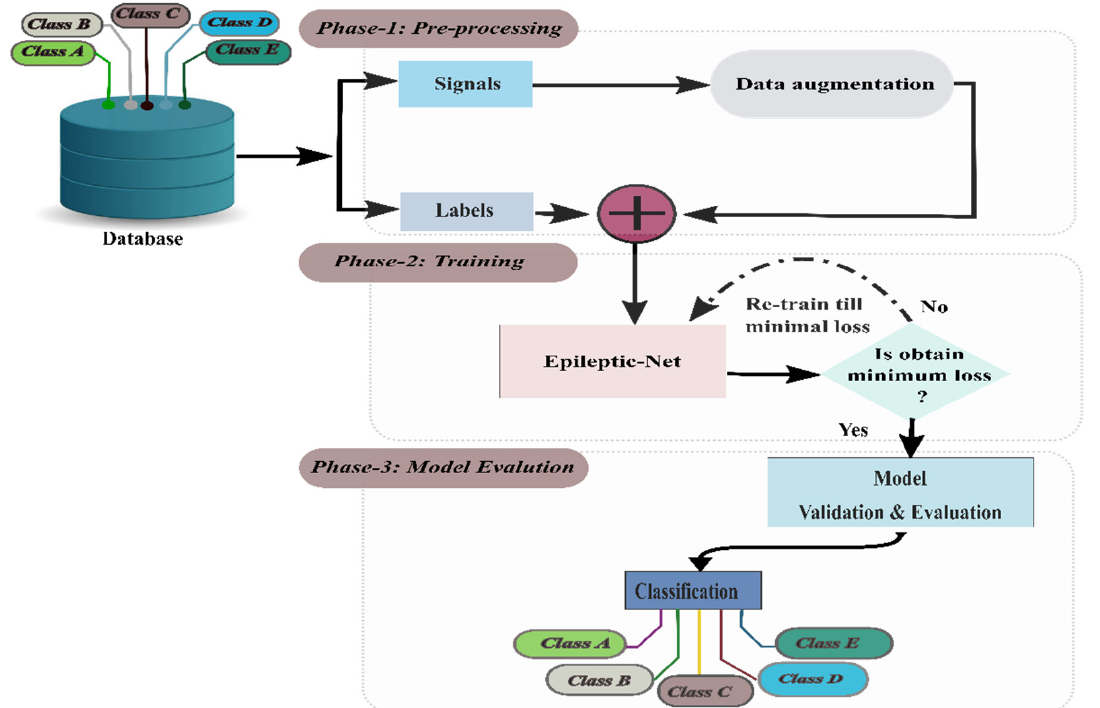
Figure 2. Block diagram of methodological steps to detect the ES.